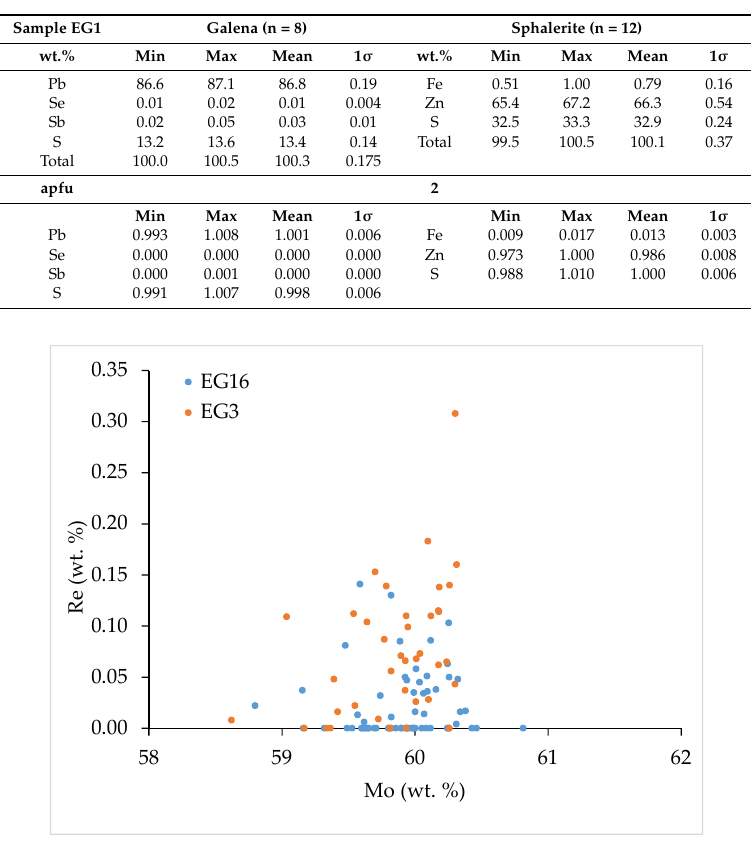
Table 4. EPMA data of galena and sphalerite from base metals veins of the Aisymi-Leptokarya prospect.